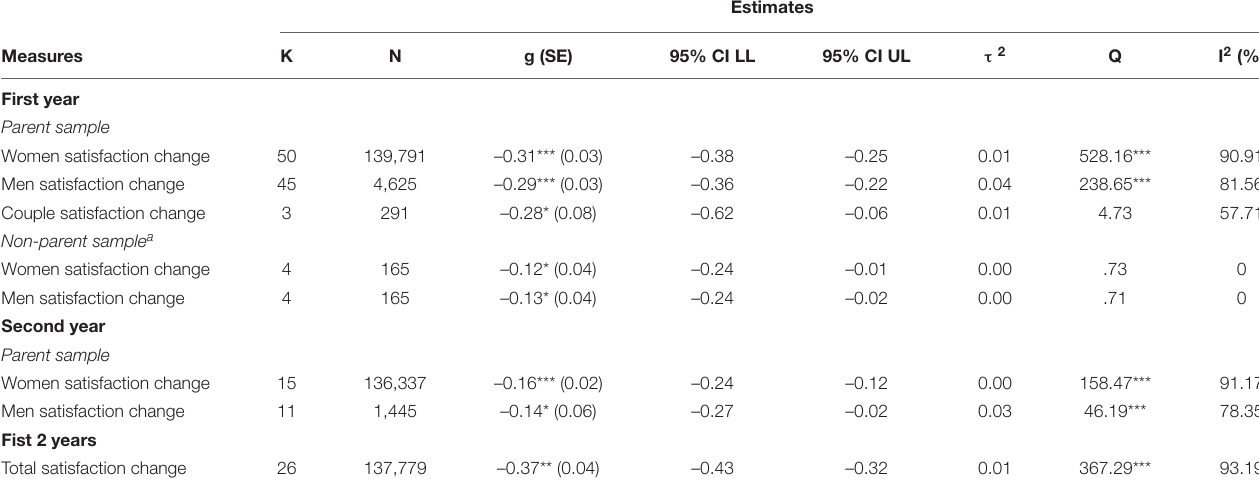
TABLE 1 | Effect size for the satisfaction decrease in the parents’ and non-parents’